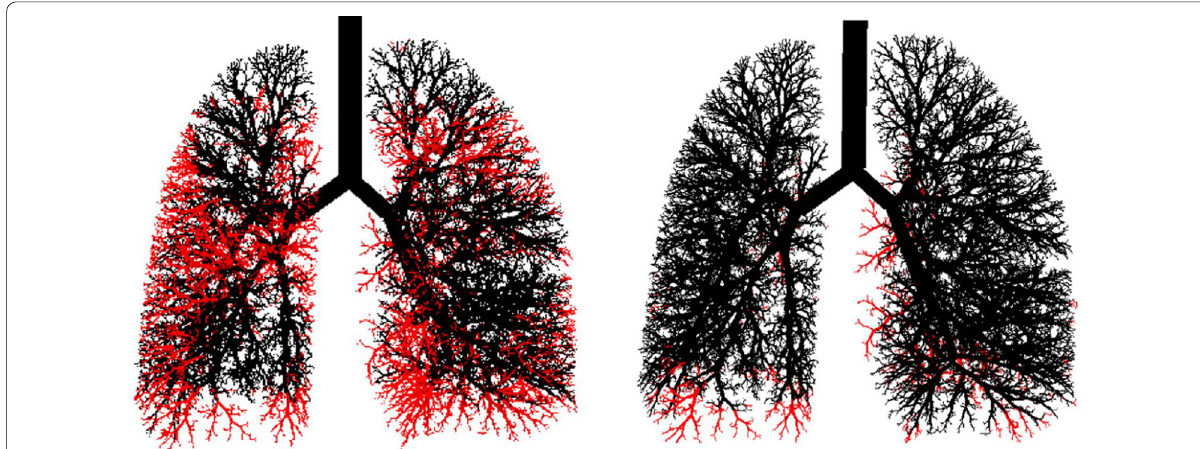
Fig. 6 A model airway tree for an asthmatic subjects following bronchoconstriction with methacholine ( left ) and following bronchodilation with albuterol ( right ). Open ventilated airways are depicted in black with closed nonventilated airways depicted in red . Note that following bronchodila- tion, most, but not all, of the airways recover (reproduced with permission from